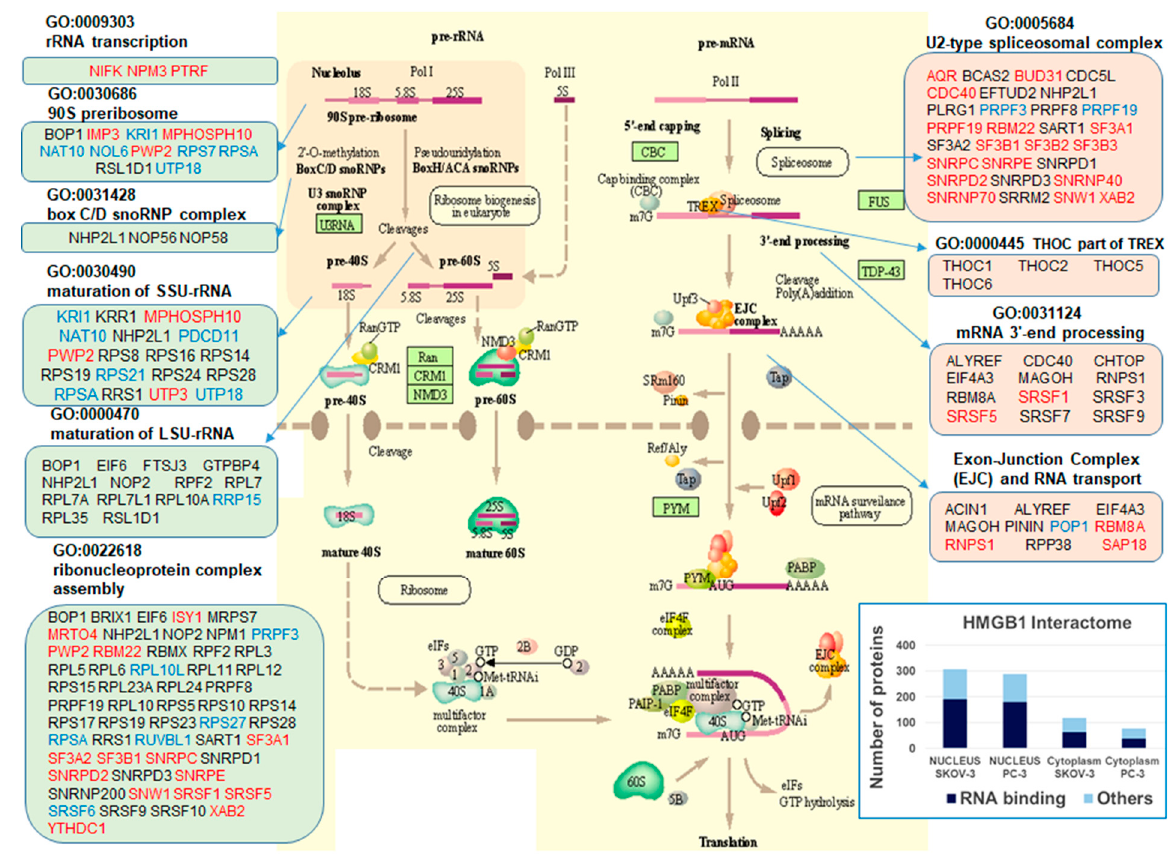
Figure 6. Mapping of HMGB1 interactome to the RNA processing and export pathways (adapted from the KEGG map RNA TRANSPORT from Kanehisa laboratories hsa03013, accessed 22 July 2020). Red, proteins found in SKOV-3; blue, in PC-3; black, in both cell lines. The graph in the bottom right box shows the total number proteins identified and those common to the RNA interactome described in HELA cells [26].